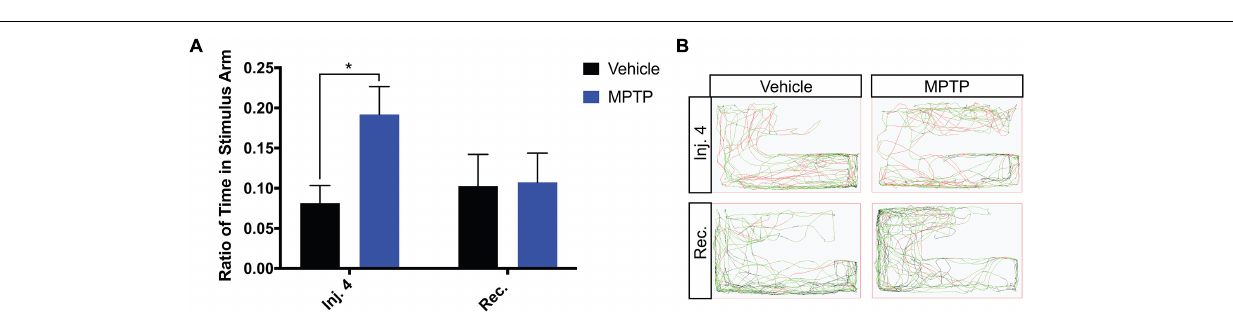
MPTP and MPP + have been shown to translate into